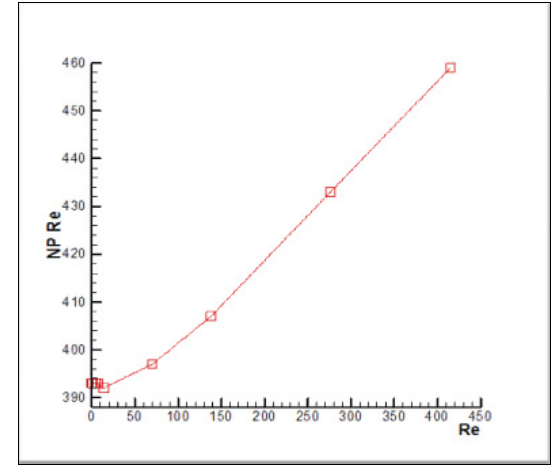
Fig. 6. Influence of the anchor on the power consumption.